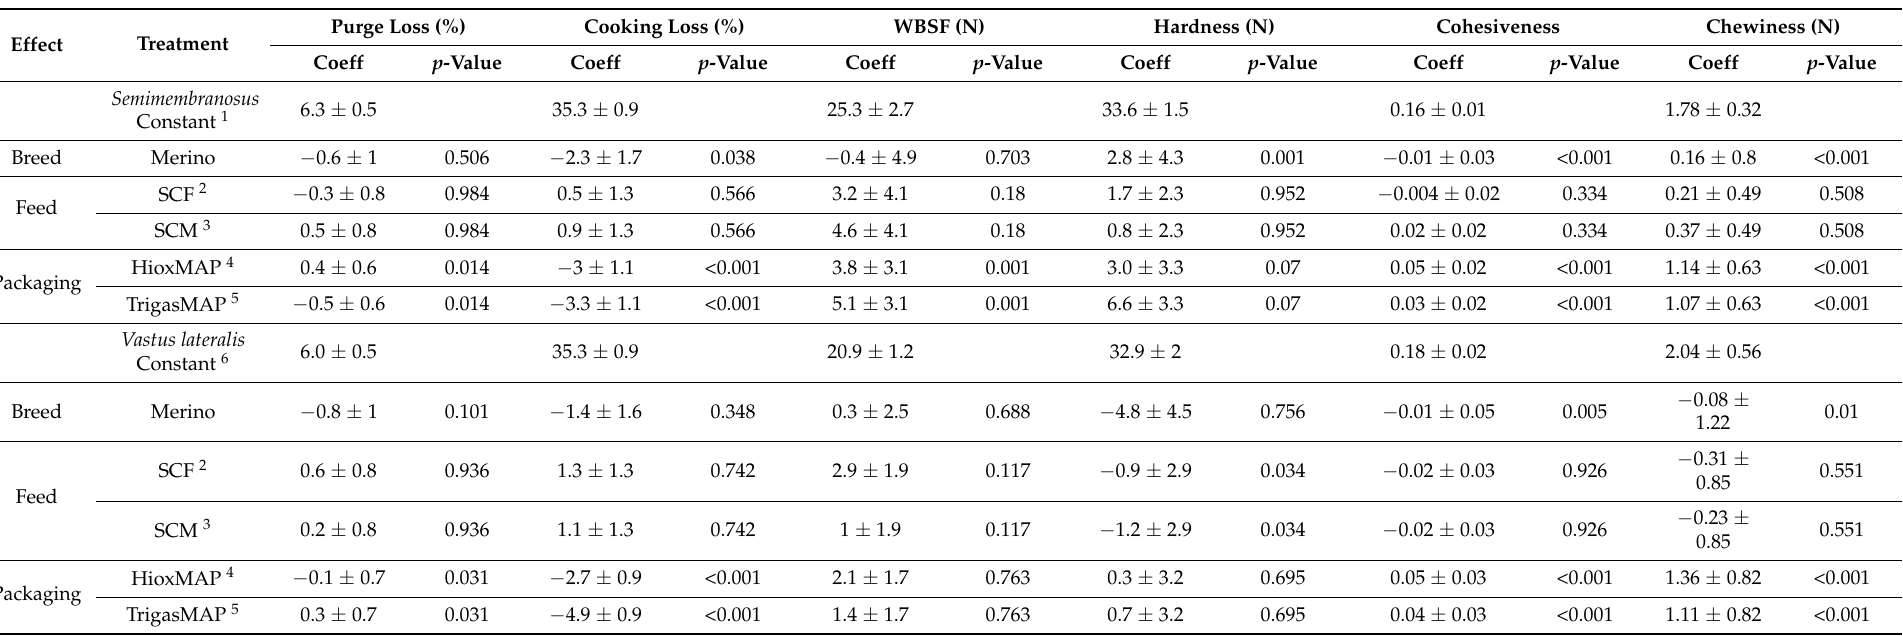
Table 2. Effect of breed, feed and packaging method on water holding capacity and texture measurements of sheep Semimembranosus (topside) and Vastus lateralis